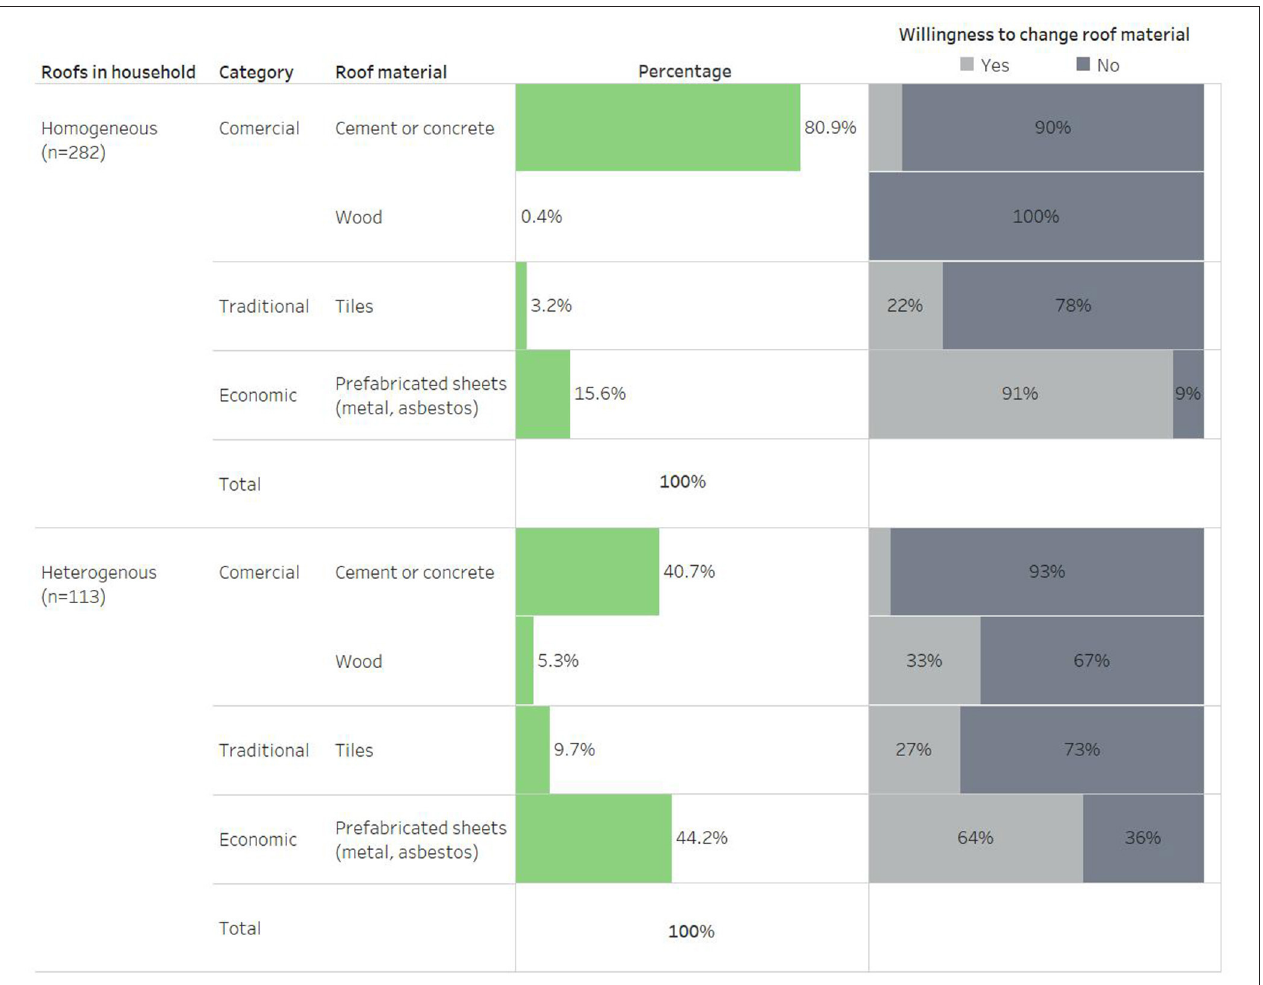
FIGURE 2 | Roof materials and willingness to change in ZMVO